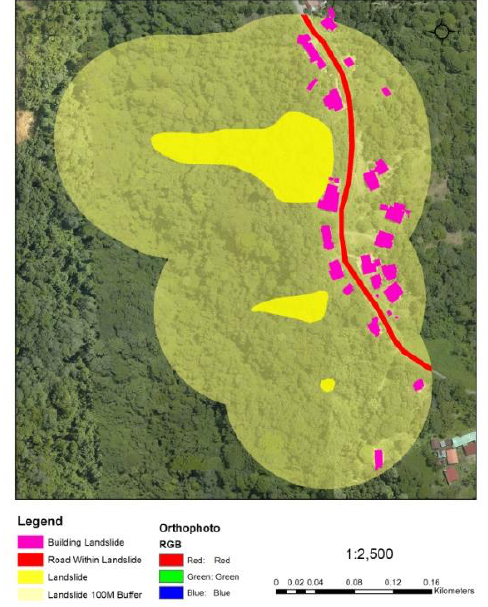
Figure 1: Illustration of how potential candidates are chosen for element at risk analysis using 100 meters buffering zone from landslide polygon.